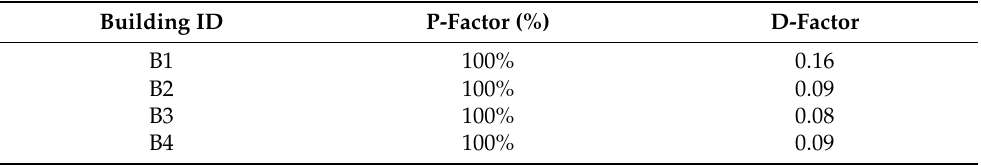
Table 4. The NARX uncertainty analysis P-factor and